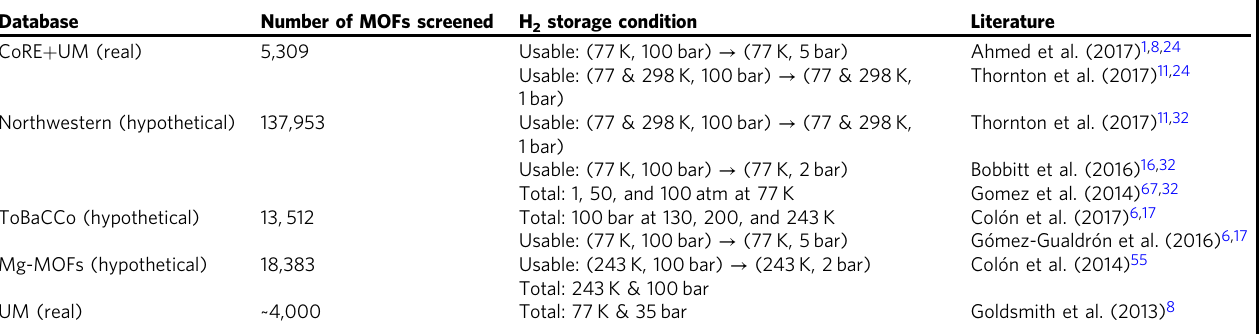
Table 1 Summary of recent high-throughput calculations of hydrogen storage in MOFs